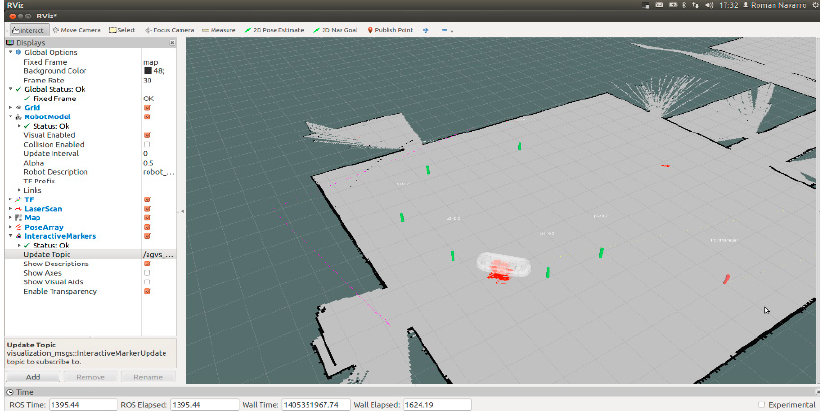
Figure 21. Rviz visualization of an AGV moving on a path.